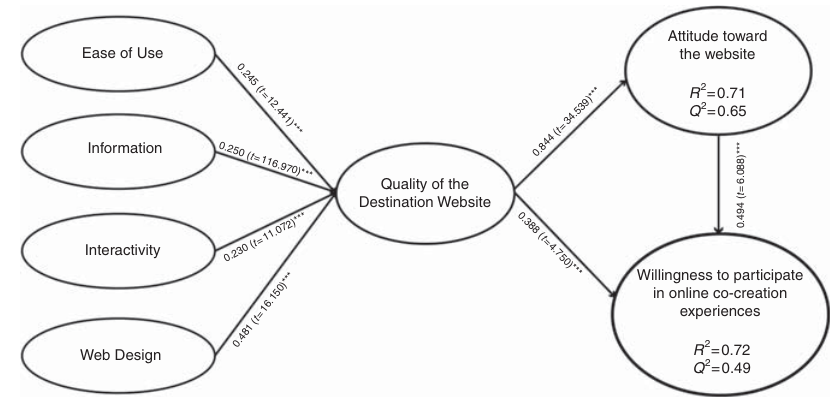
Figure 2. Results of the relational